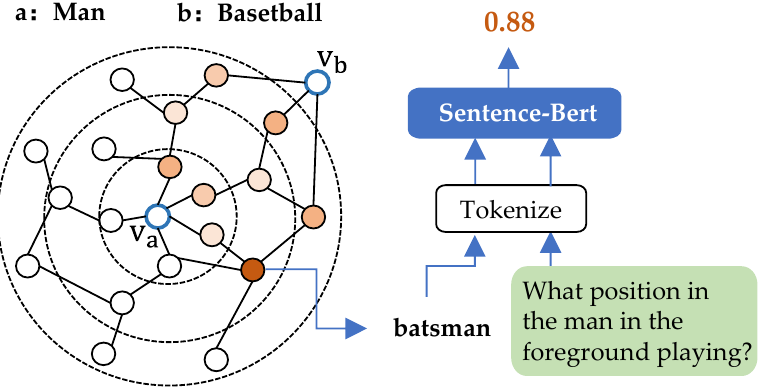
Figure 3. Process of identifying multi-hop nodes and implementing denoising operations for nodes v a and v 𝑏 in the knowledge graph.